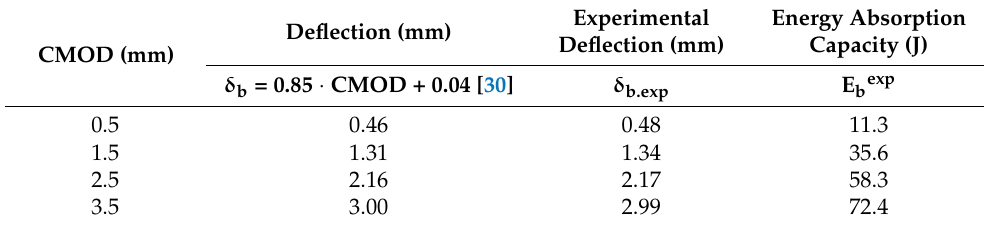
Table 4. The CMOD and the corresponding beam deflection values ( δ b ), ( δ b.exp ) and bending energy (E bexp